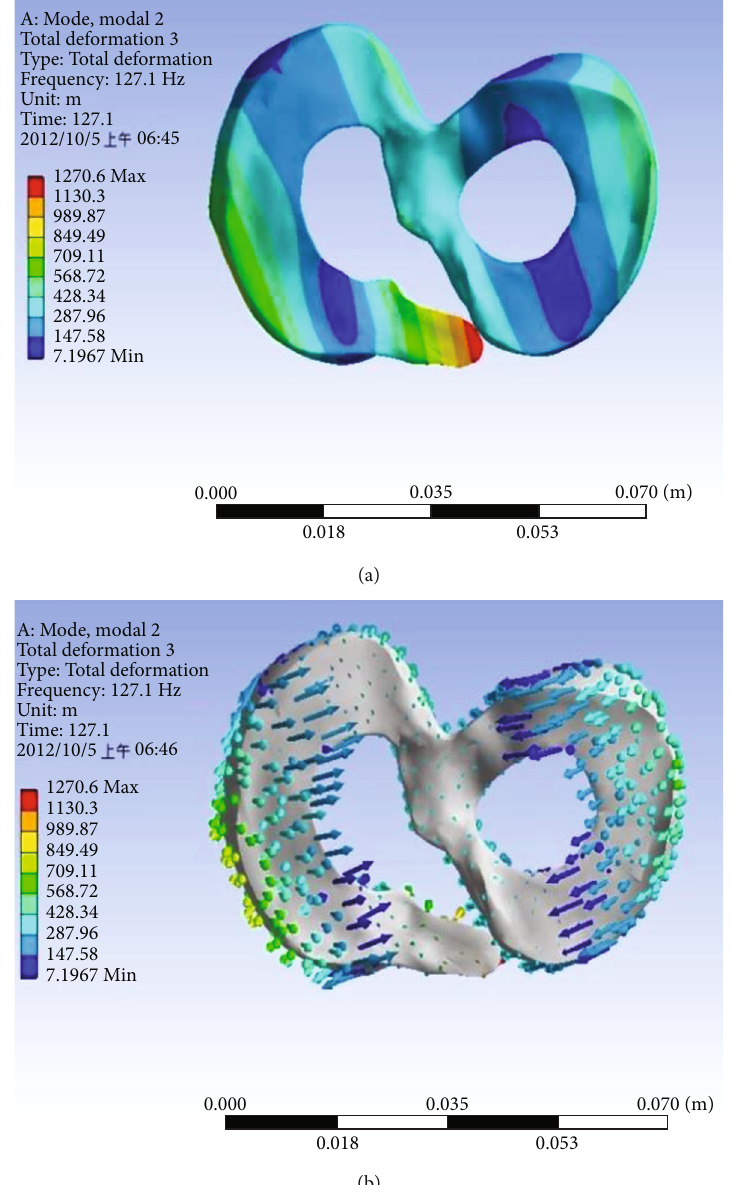
Figure 7: Third mode shape of meniscus model at 127.1Hz (bending vibration via thickness direction). (a) Third mode shape. (b) Vector plot of third mode